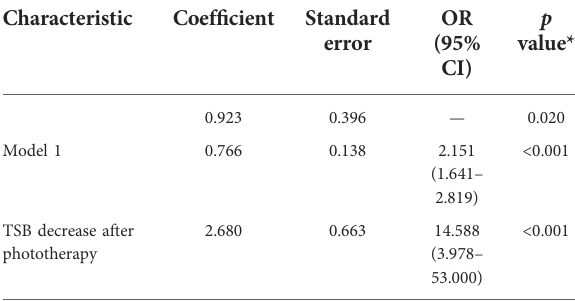
TABLE 5 Model 2 created with linear predictive value of Model 1 and TSB decrease after phototherapy.